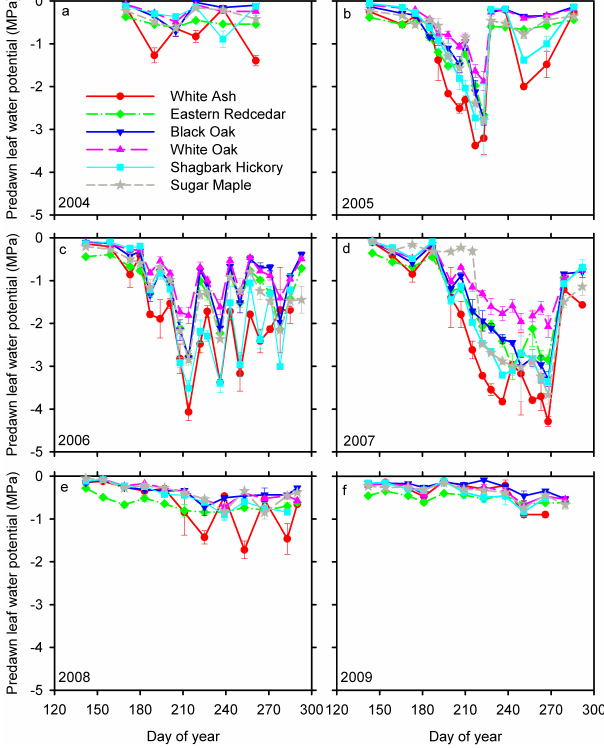
Figure 2. Seasonal variations in predawn leaf water potential of different species from 2004 to